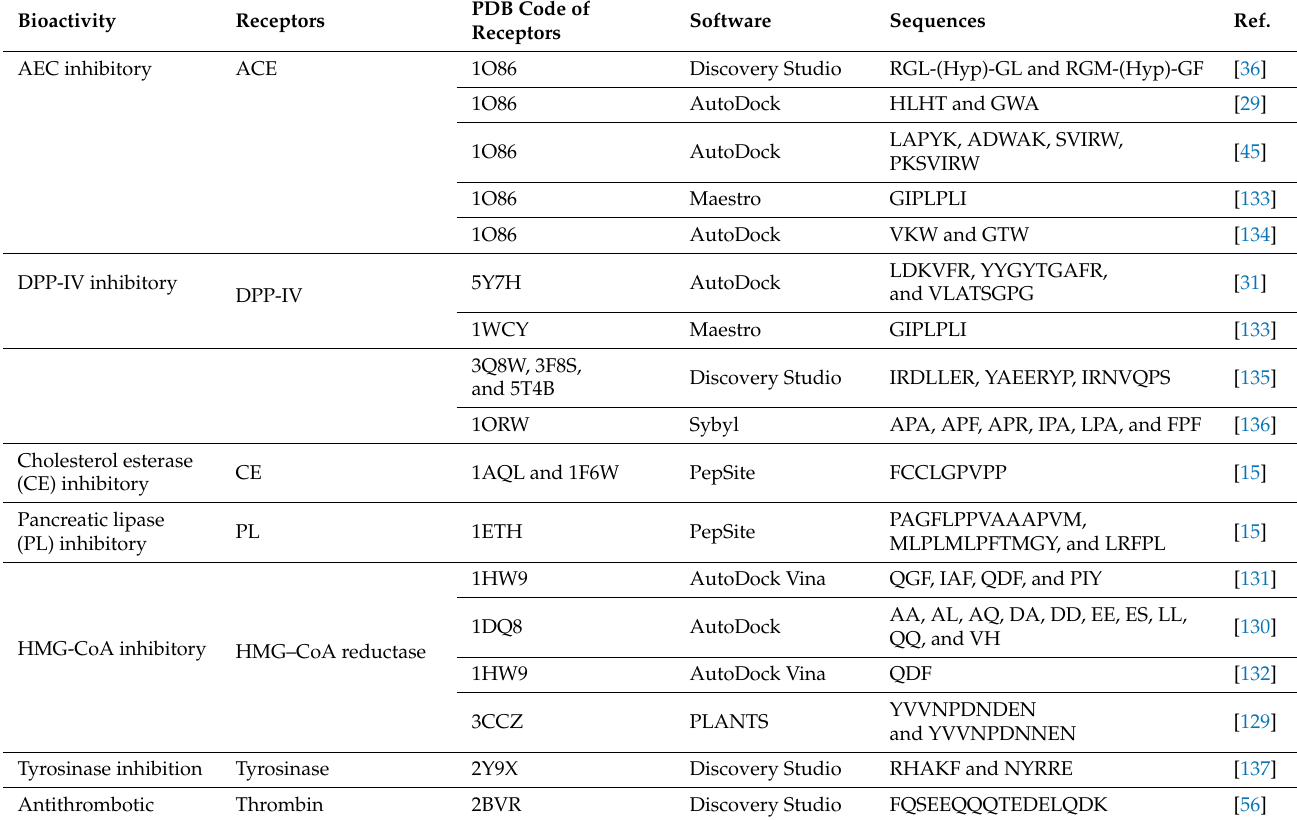
Table 2. Molecular software sources studied on the interaction of bioactive peptides and